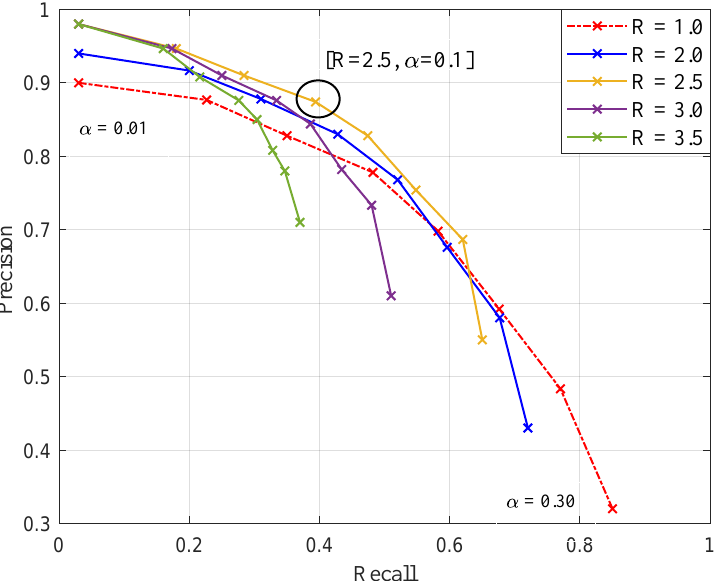
Figure 9. Joint evolution of recall–precision (for mildew pixels) for different combinations of thresholds for the determination of seeds. Each cross represents a value of α ∈ [ 0.01,0.30 ] with low values starting top-left to